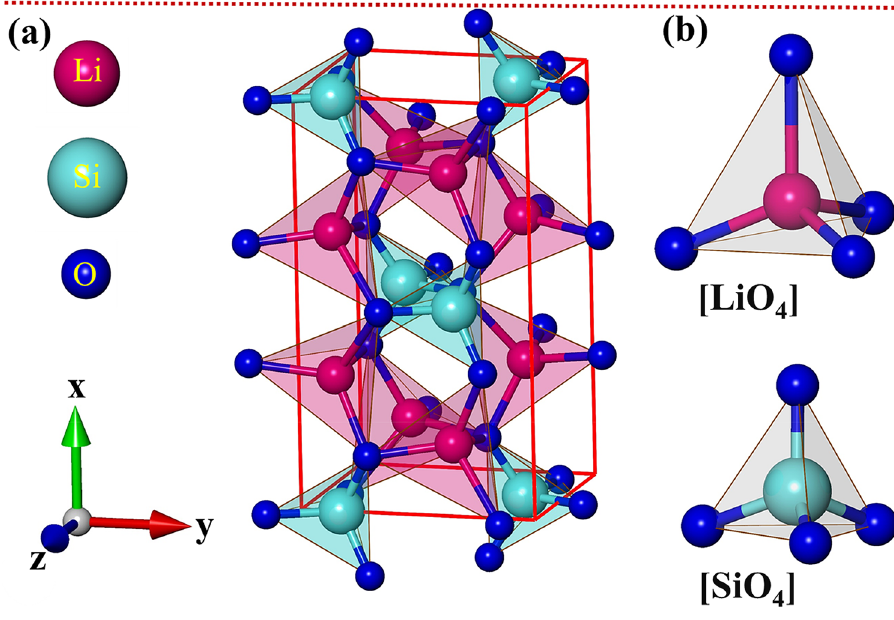
Figure 1. ( a ) The optimal geometric structure of the Li 2 SiO 3 compound. Unit cell is a solid red ( b ) oxygen atoms around each Li/ Si atom.